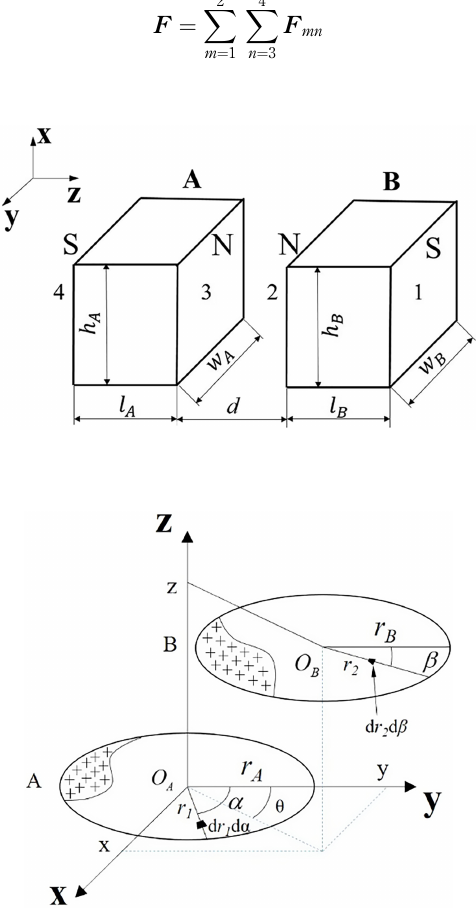
Figure 11. Coordinate system of interacting circular magnetic pole